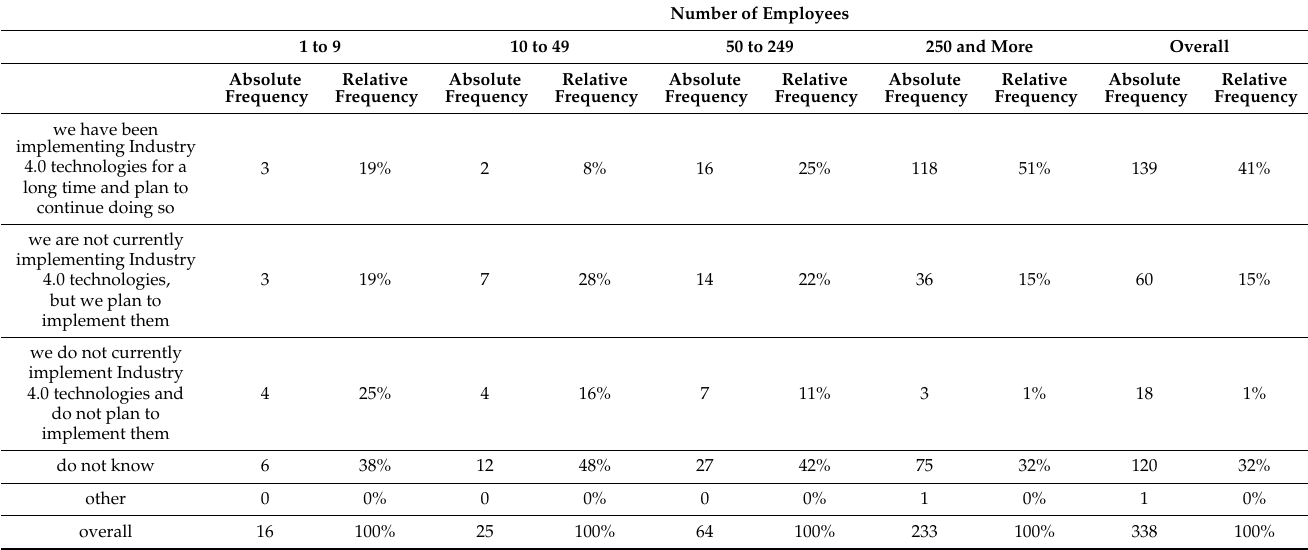
Table 3. Implementation of Industry 4.0 in the organization.